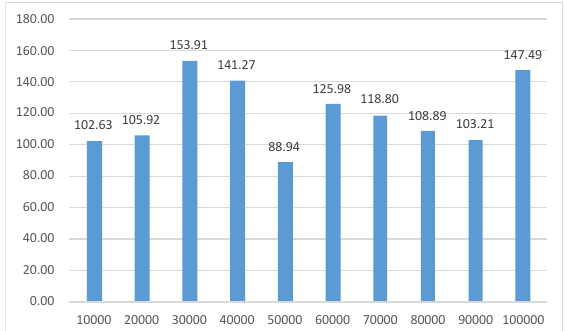
Fig. 10. The average speedup of GPU programs on different size of dataset. In the figure, the X axis represents the size of dataset (number of records) and the Y axis represents the speedup of GPU kernels.